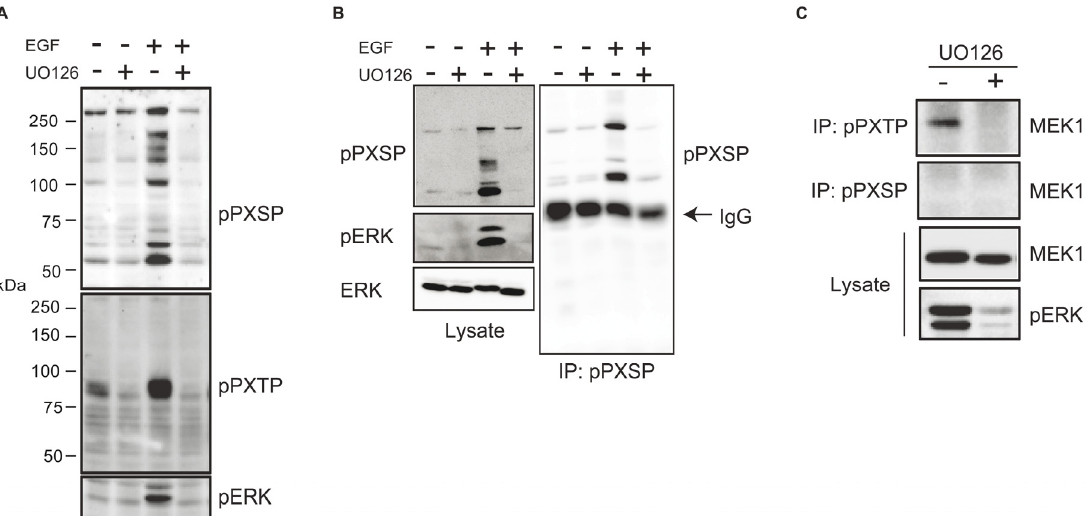
Figure 1. ( A ) Phospho-motif antisera recognize potential ERK substrates. Serum-starved cultures were pre-treated with or without the MEK inhibitor UO126 before stimulation with EGF for 10 min. Lysates were blotted with anti-phospho PXSP, anti-phospho PXTP or anti-phospho ERK antisera. ( B ), ( C ) Phospho-motif antisera immunoprecipitate known and potentially novel ERK substrates. Lysates prepared as in ( A ) were immunoprecipitated (IP) with anti-phospho PXSP ( B ) or anti-phospho PXTP ( C ) antisera. Immunoprecipitates were blotted with anti-phospho PXSP antiserum ( B ) or with antiserum to MEK1, a known ERK substrate ( C